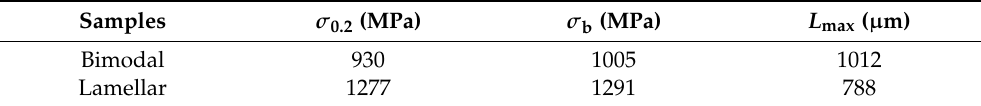
Table 2. The in situ tensile mechanical properties of bimodal and lamellar microstructure at 350 °C. Samples Bimodal